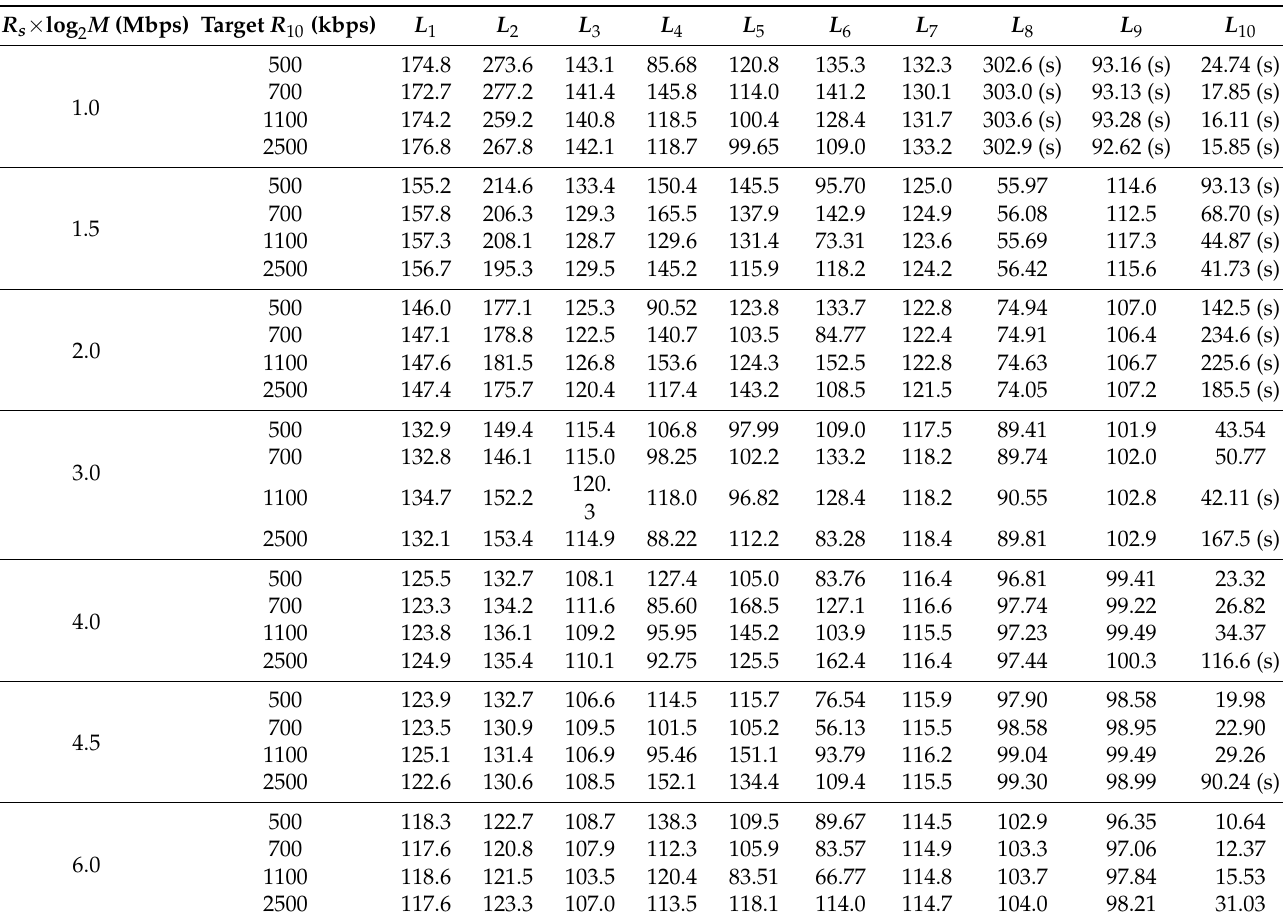
Table 15. Examples of L i